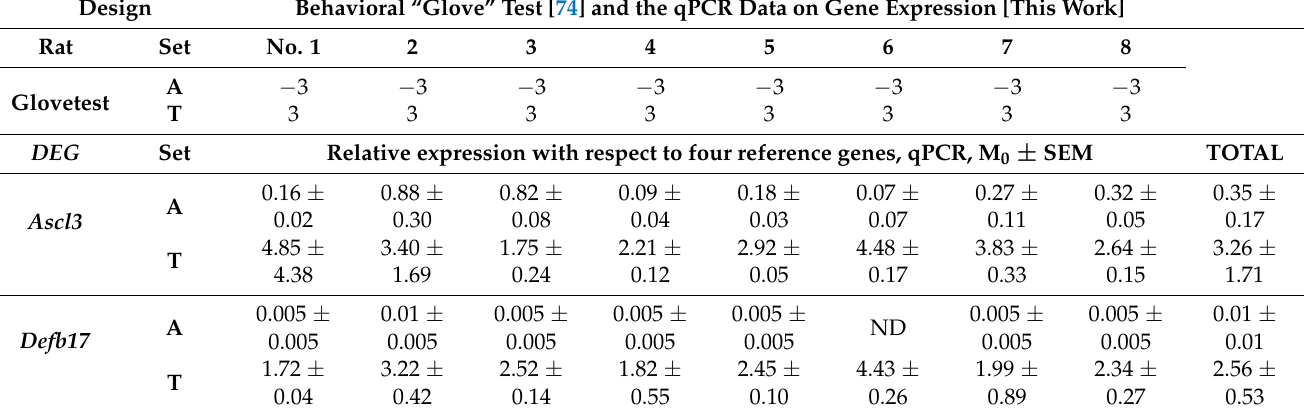
Table 3. qPCR data on the selected DEGs from the hippocampus of the independently obtained eight tame adult male rats and eight other aggressive ones (all unrelated animals).